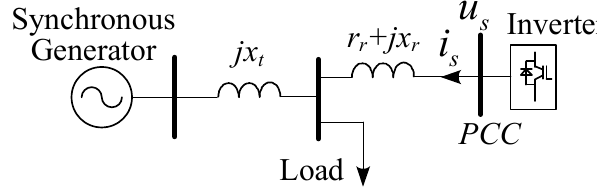
Figure 7. The circuit diagram of the study system. Figure 8 [16]. In Figure 8, i d and i q are the d axis component and q axis component of i s . It can be seen from Figure 8 that after the fault occurs, the generalized synchronization stability between the generator and the inverter is lost because the PLL cannot lock the rotor angle of the synchronous generator, resulting in divergent oscillations of the physical quantity of the system. It has been demonstrated in reference [16] that when the AC system short-circuit ratio of the inverter is less than 1.4, phase locking failure of the PLL is likely to